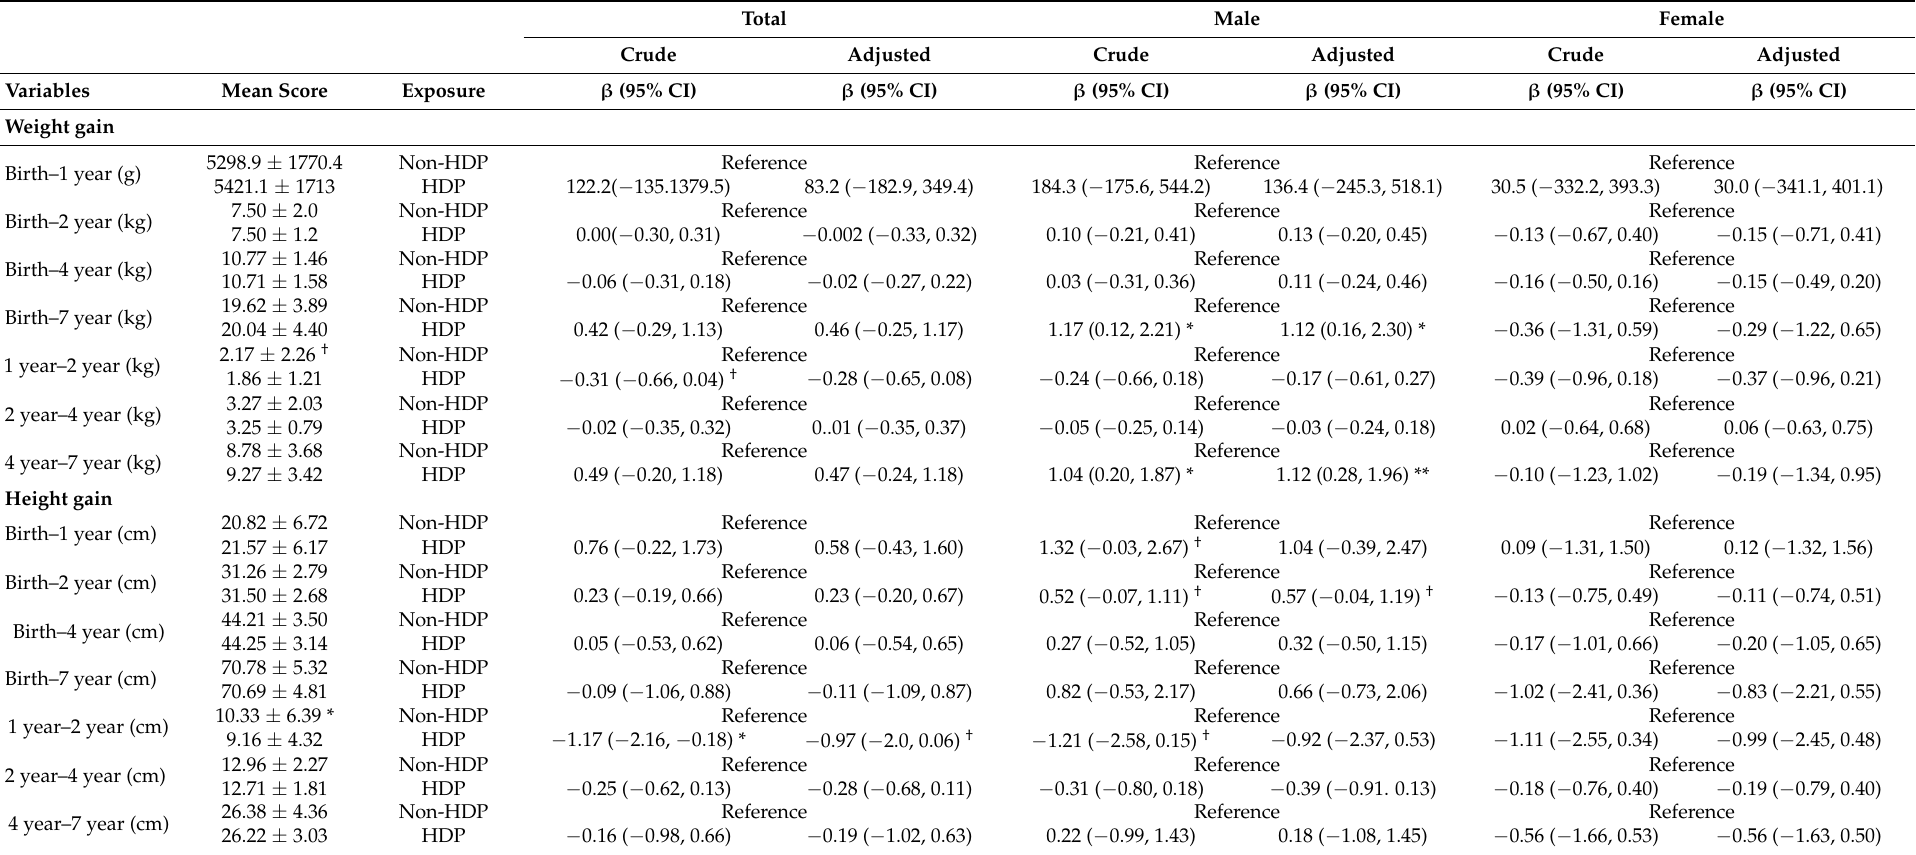
Table 6. Difference in weight and height gain from birth to different years of ages and at different age intervals using the multiple linear regression models. Total Male